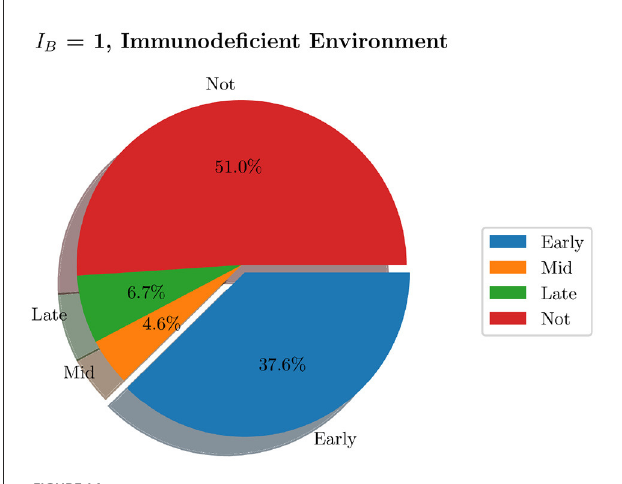
FIGURE14 Pie charts summarizing bacterial clearance status for simulations with and immunocompromised environment, I B =